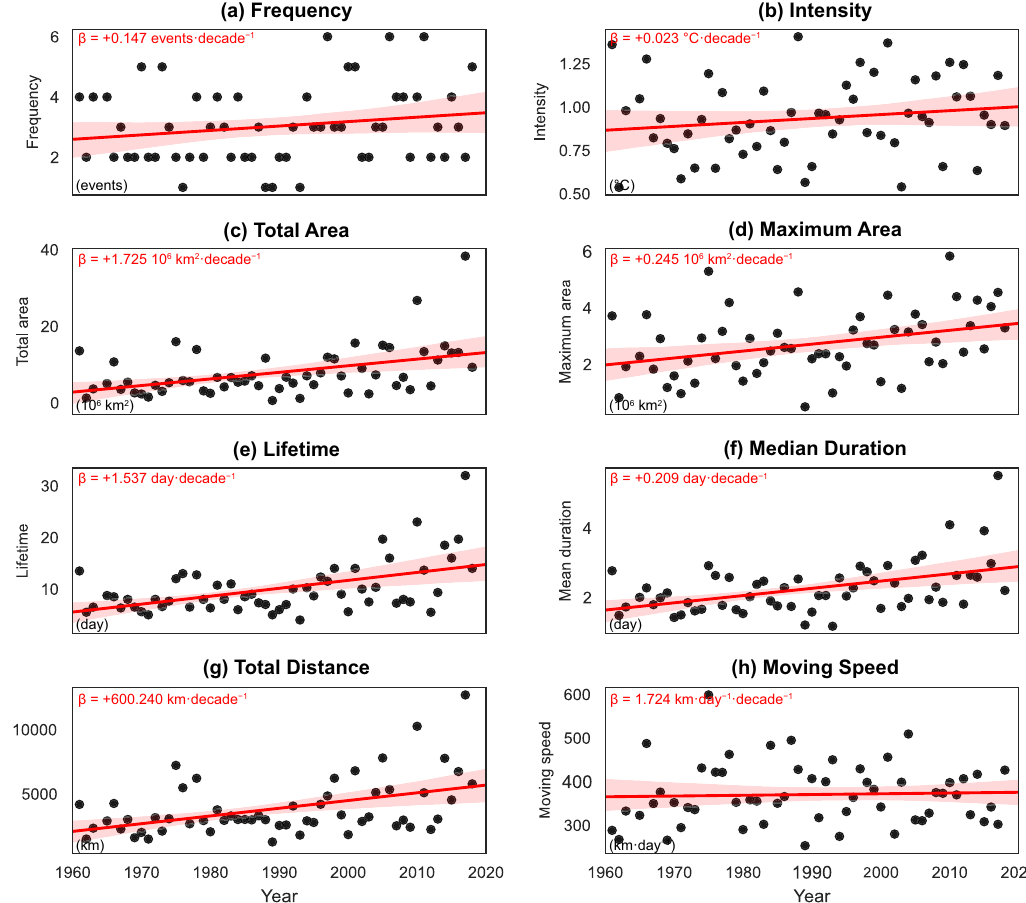
Fig. 5 Time series of the yearly statistics of Type 2 contiguous heatwaves during 1961 – 2018. a Time series of the yearly frequency of the contiguous heatwave. b – h As ( a ) but for intensity, total area, maximum area, lifetime, median duration, total moving distance, and moving speed, respectively. The red straight line indicates the corresponding linear trend, with the red text indicating the trend magnitude. The pink shading indicates the 95% con fi dence interval of the fi tted line. All trends are statistically signi fi cant at the 0.05